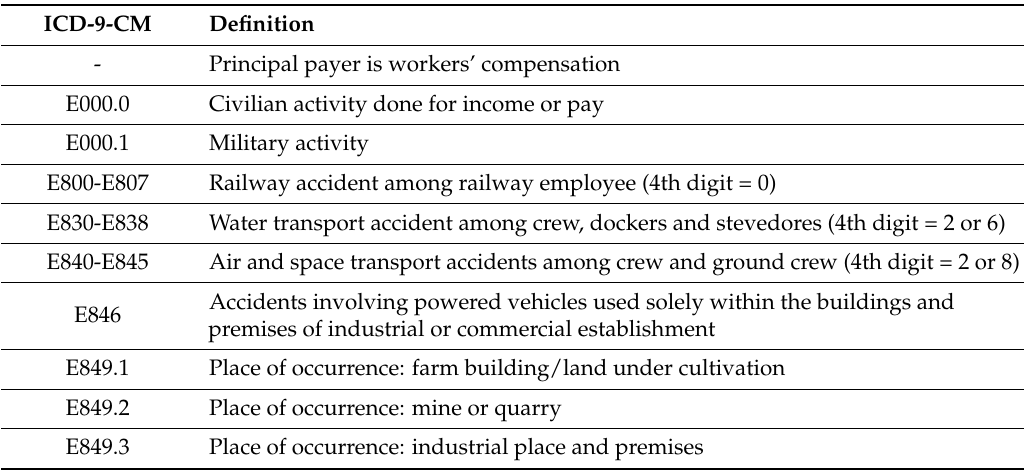
Table 1. Description of codes used to define work-relatedness within the morbidity